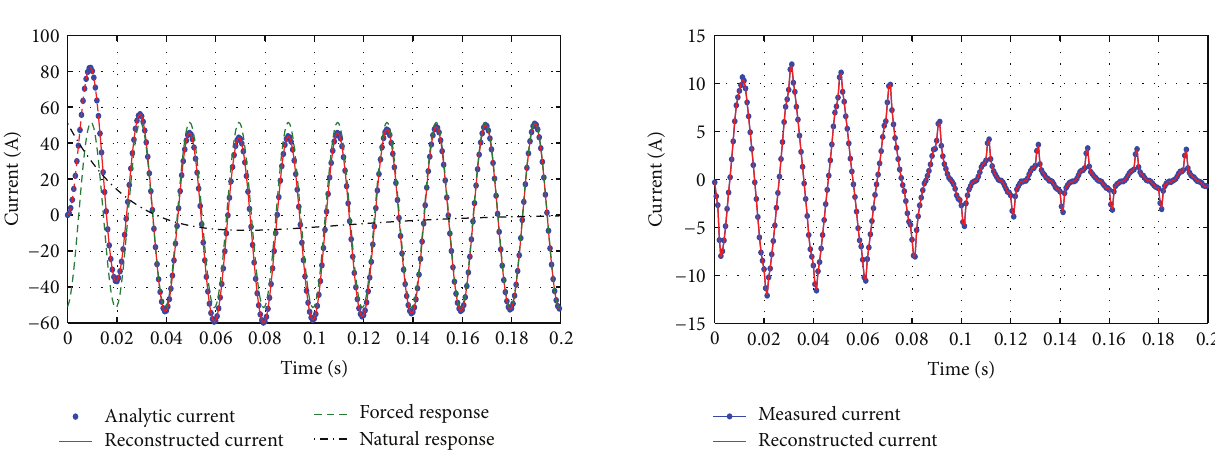
Figure 4: The analytic and reconstructed currents of the series RLC circuit along with its forced and natural responses.